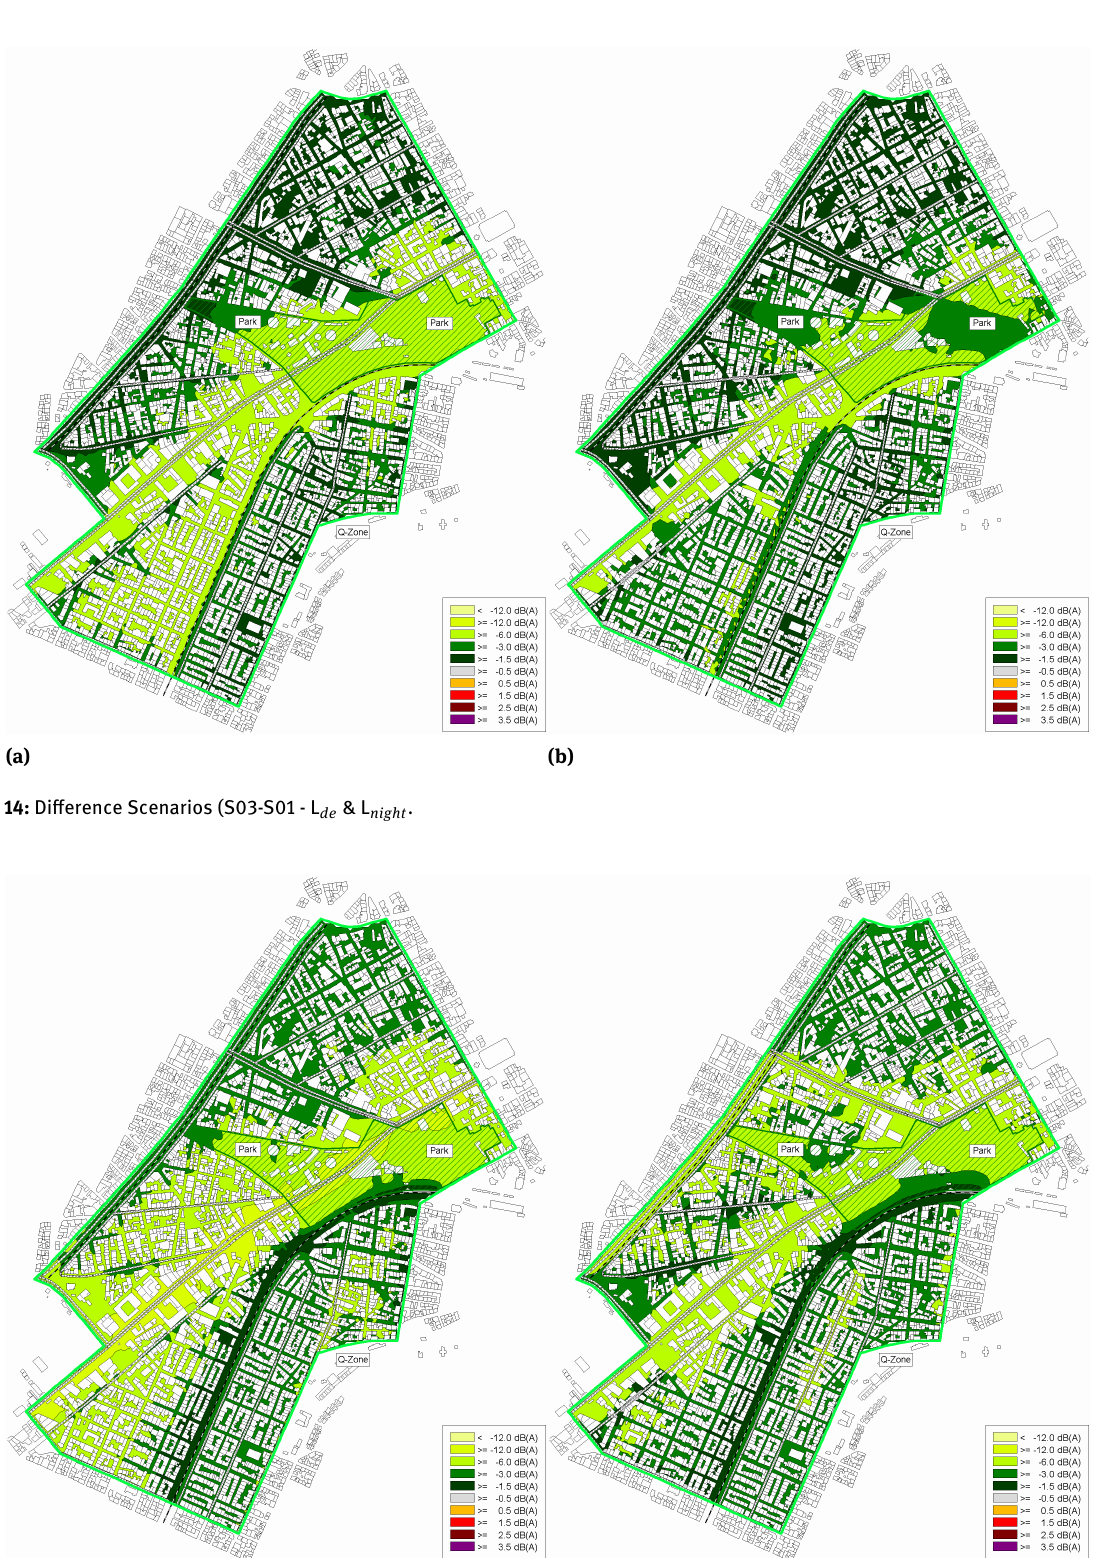
Figure 15: Difference Scenarios S04-S01 - L